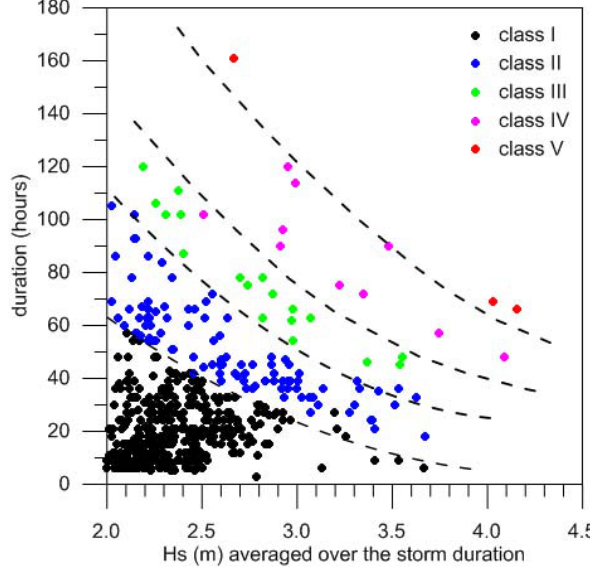
Fig. 5. Storm-averaged H s and duration for each category for all the recorded